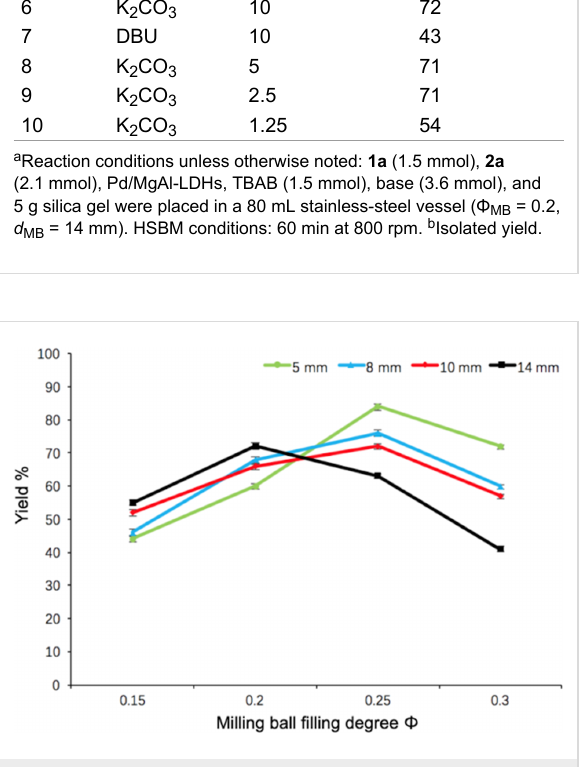
Figure 2: Examination of the milling-ball filling degree ( Φ MB ) and milling-ball sizes on the yield of 3aa . Reaction conditions: 1a (1.5 mmol), 2a (2.1 mmol), Pd/MgAl-LDHs (2.5 mol %), TBAB (1.5 mmol), K 2 CO 3 (3.6 mmol), 5 g silica gel were placed in a 80 mL stainless-steel vessel. HSBM conditions: 60 min at 800 rpm.